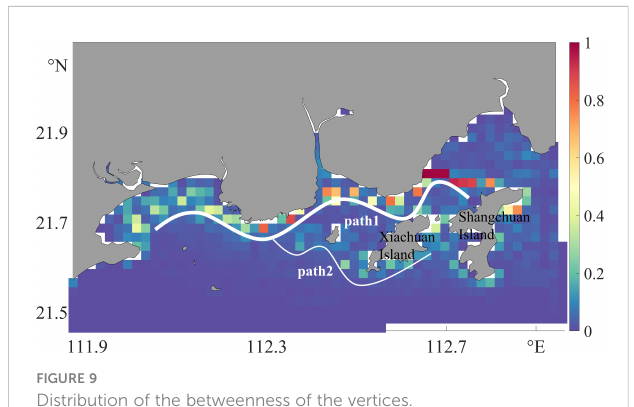
FIGURE 9 Distribution of the betweenness of the vertices.